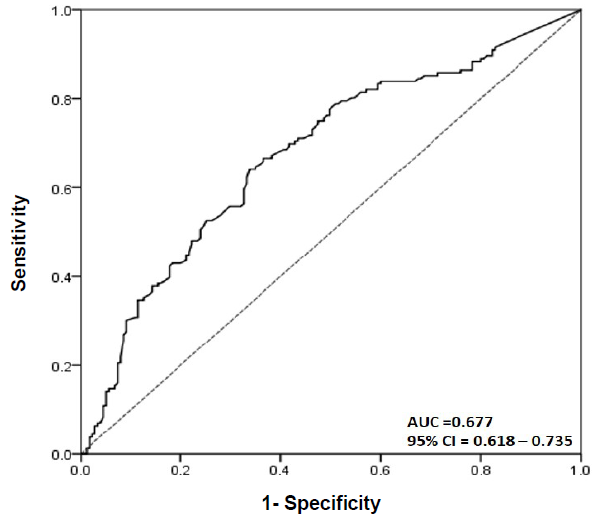
Figure 4. The ROC curve for EAT thickness to predict max LCBI 4mm ≥ 400.